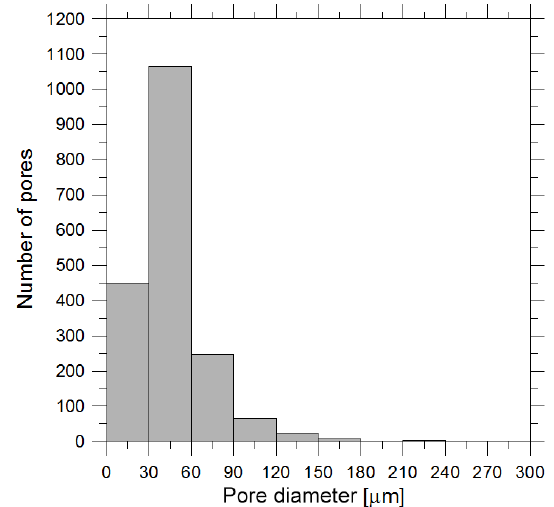
Figure 7. Result of the pore-size distribution for an REV-scale sub- volume arbitrarily placed in the sample approximation as number of pores vs. pore diameter, whereas pore diameters were unified in 30µm intervals. Due to representation, this figure excludes the pore representing the maximum pore diameter d Pore, max , which exceeds the pore diameter range